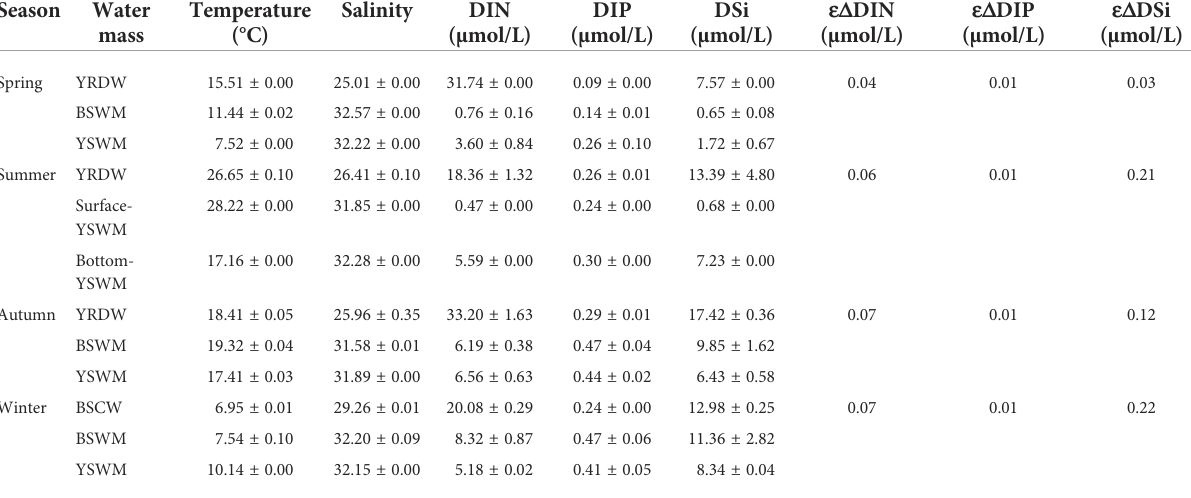
TABLE 1 Summary of the end-member values and their average uncertainties ( e ) used in three end-member.